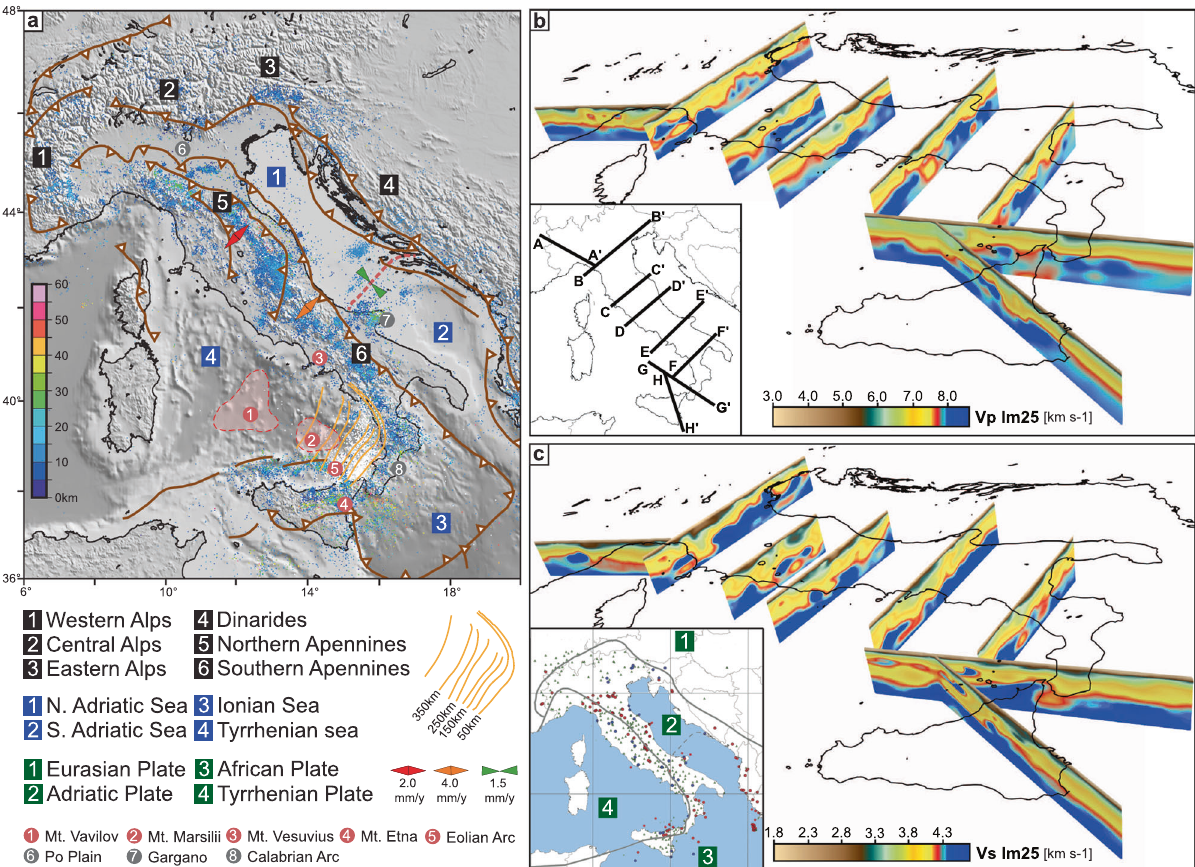
Fig. 1 Tectonic setting of Italy and vertical cross-sections of model Im25 . a Map of the main tectonic and structural features of the Italian region (modi fi ed after 3 ); deformation rates 6 are denoted by colored arrows (see legend). Relocated seismicity from the Italian Bulletin of INGV 85 is represented by the dots, colored by earthquake depth. Isolines indicate the deepening of the Ionian slab 86 . The light red areas indicate volcanic provinces. b Vertical sections of the Im25 V p model visualized in 3D; coastlines are plotted on top of the slices. See inset for a map view. c Corresponding vertical sections for the Im25 V s model. The inset shows earthquakes (dots) and stations (triangles) used in this study. Red dots are the 123 events considered for the fi rst 12 iterations, blue dots denote 40 events added at the 13 th iteration. Grey lines indicate a schematic representation of plate boundaries at Moho depth (modi fi ed after 6,29,87,88 ). The dashed line in the Adriatic Sea represents the theoretical separation between the two microplates that compose the Adriatic plate 6